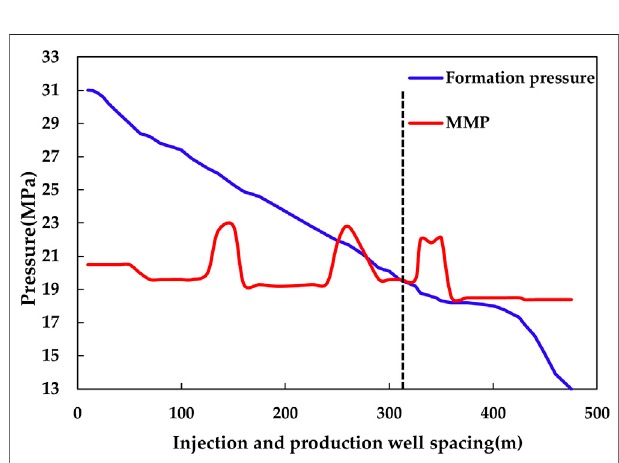
FIGURE 14 | Formation pressure vs . MMP in steady fl ow phase.